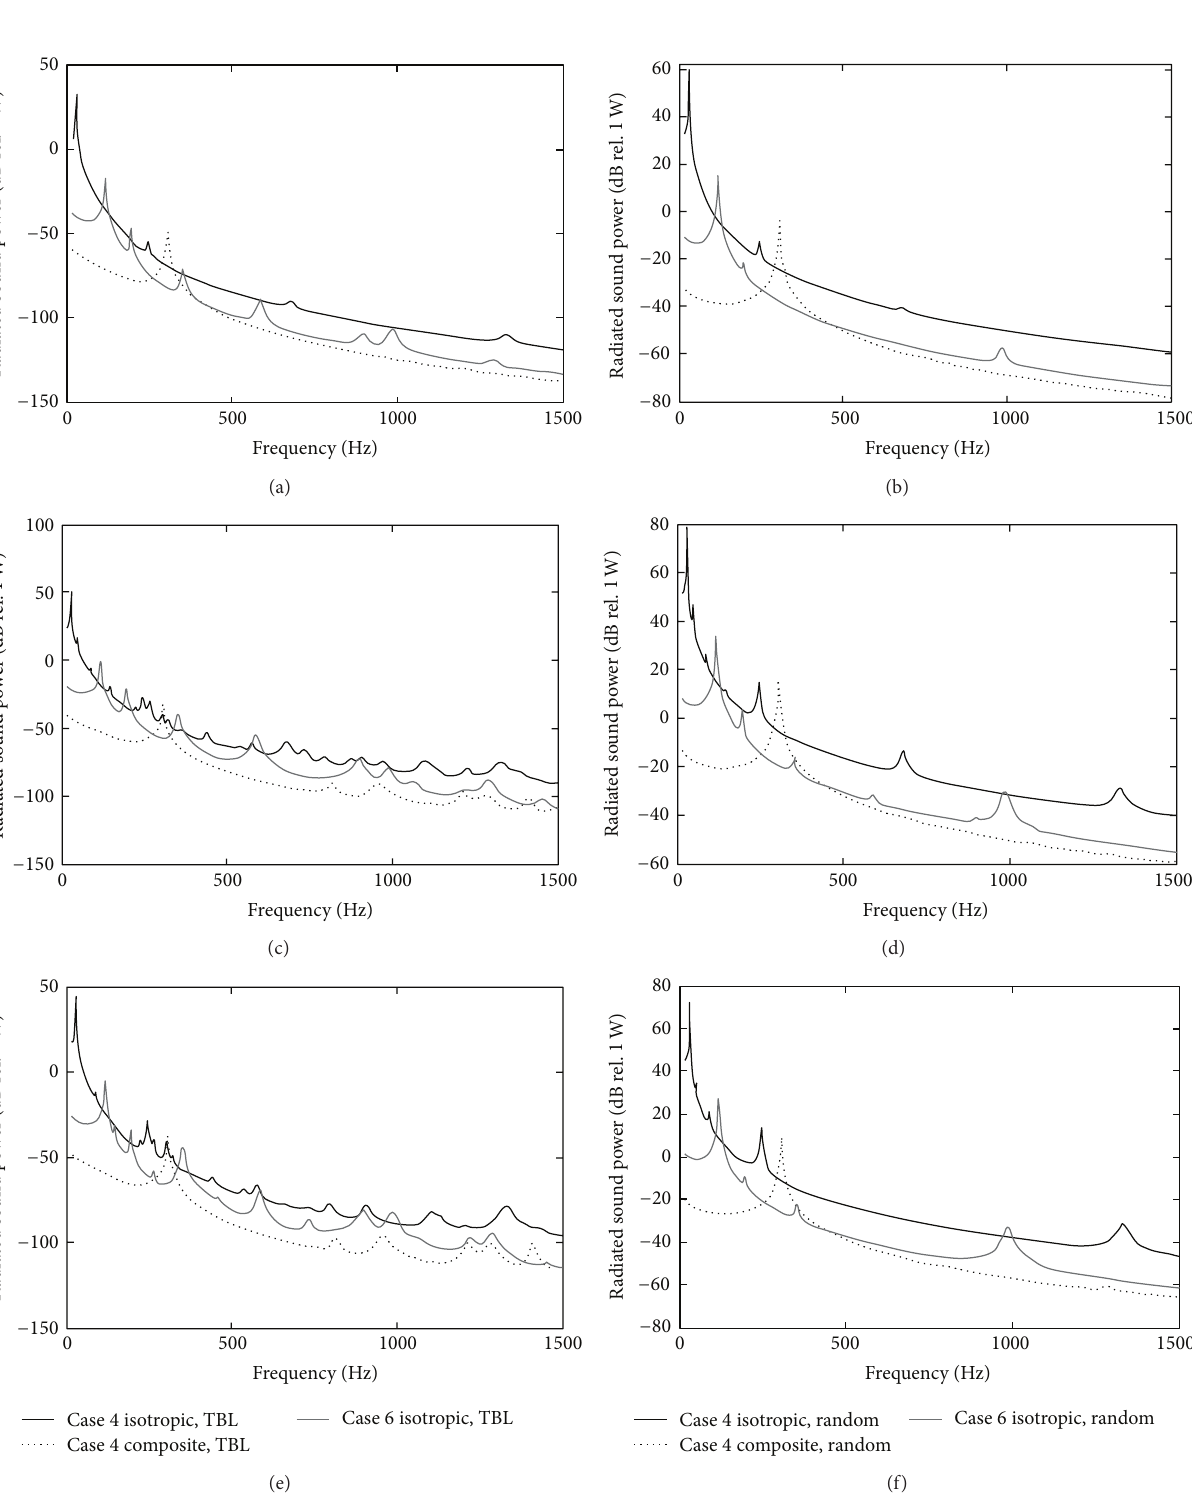
Figure 10: Comparison of radiated sound power results, for Case 4 composite panel versus Cases 4 and 6 isotropic panels: (a) and (b) overall panel RSP; (c) and (d) RSP near surface location (𝑥 1 ,𝑦 1 ) = (0.5𝑎, 0.5𝑏) ; (e) and (f) RSP near location (𝑥 2 ,𝑦 2 ) = (0.3𝑎, 0.2𝑏)